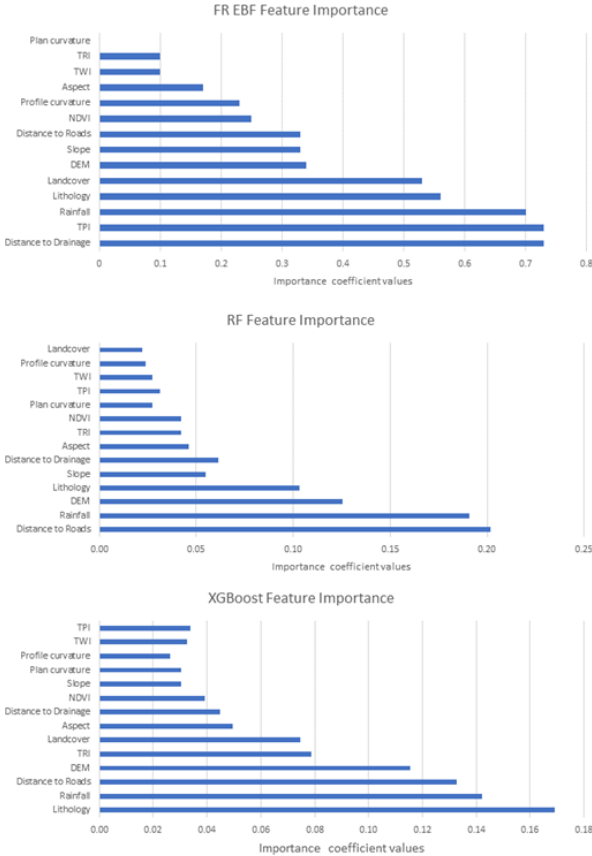
Figure 12. Importance of the features in both statistical and ma- chine learning